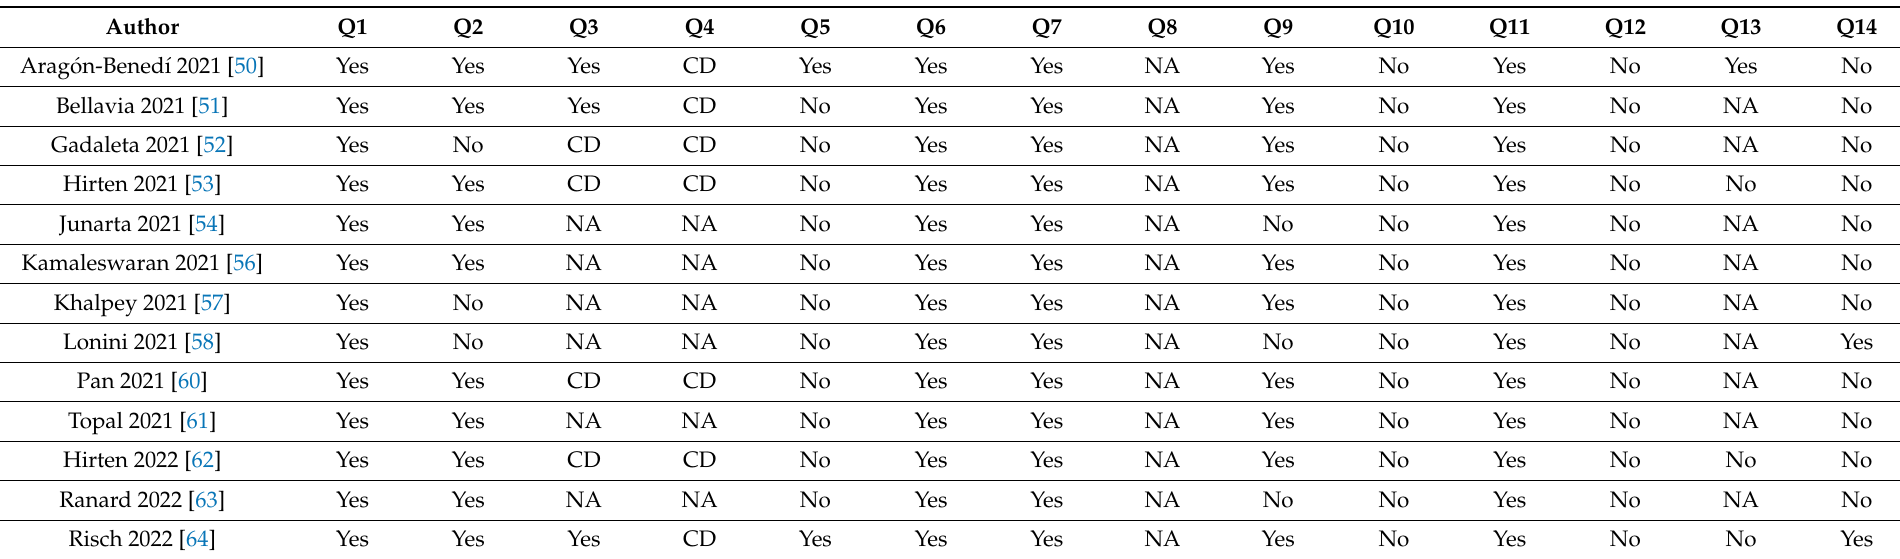
Table 3. Methodological qualities of included studies with other